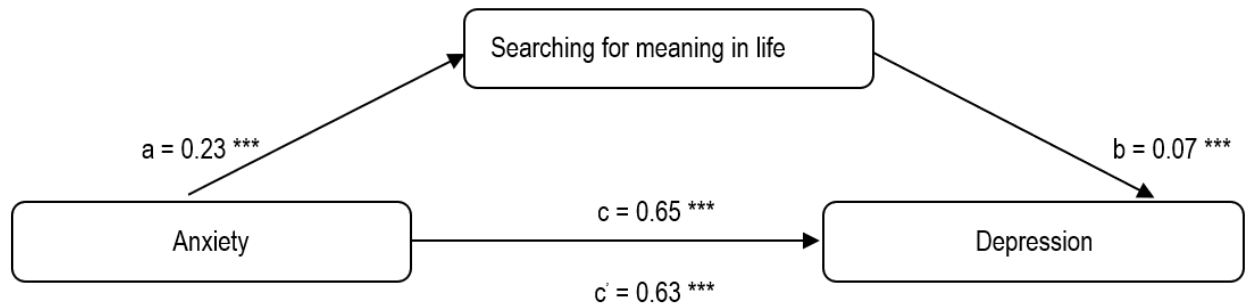
Figure 2. Results of mediation analysis of searching for meaning in life in the relationship between anxiety and depression. *** p < 0.001 .